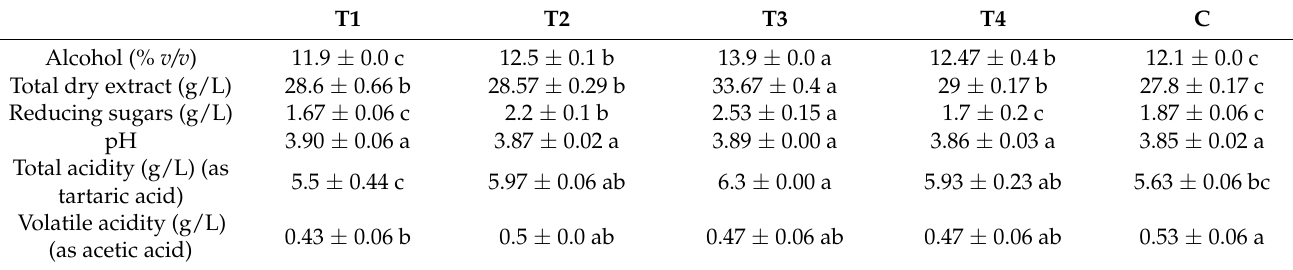
Table 2. Basic physiochemical parameters of Trnjak wines subjected to preflowering (T1), after berry set (T2) and veraison (T3) defoliation and cluster thinning (T4) treatments compared to untreated control